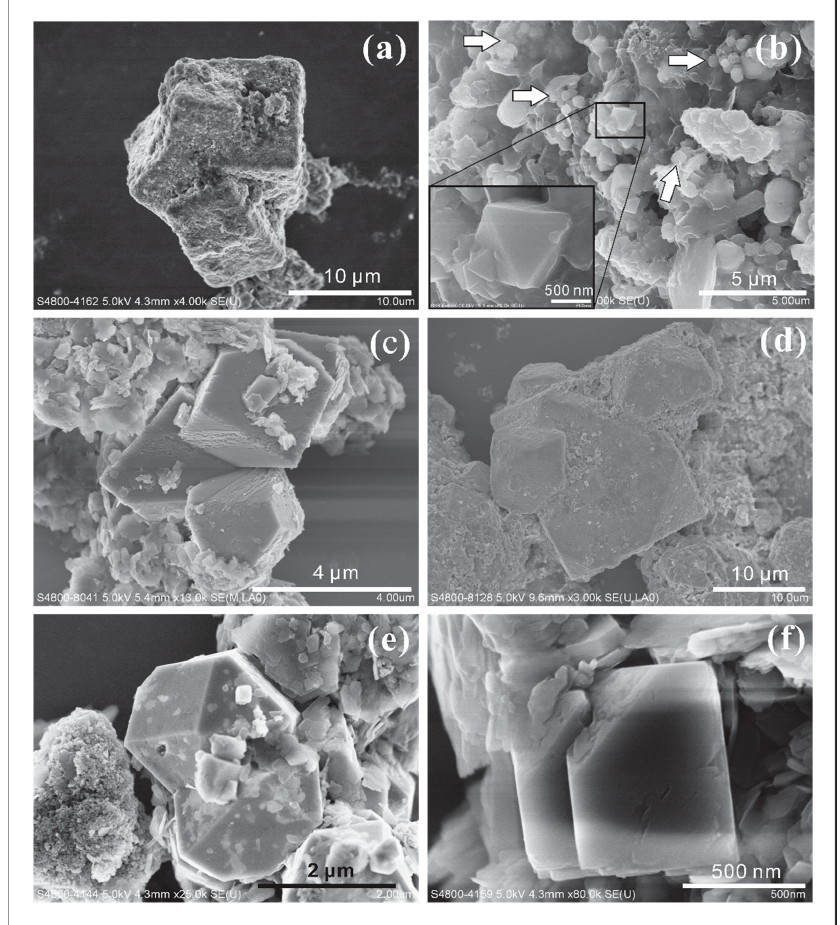
Figure 9. SEM images of different types of intergrowths of pyrite crystals ( a – f ). The inset at the bottom-left of ( b ) was the amplification of the highlighted area. ( c ) Pyrite crystals intergrowth. ( e ) Pyrite twin crystals. ( f ) Pyrite crystal parallel growth.